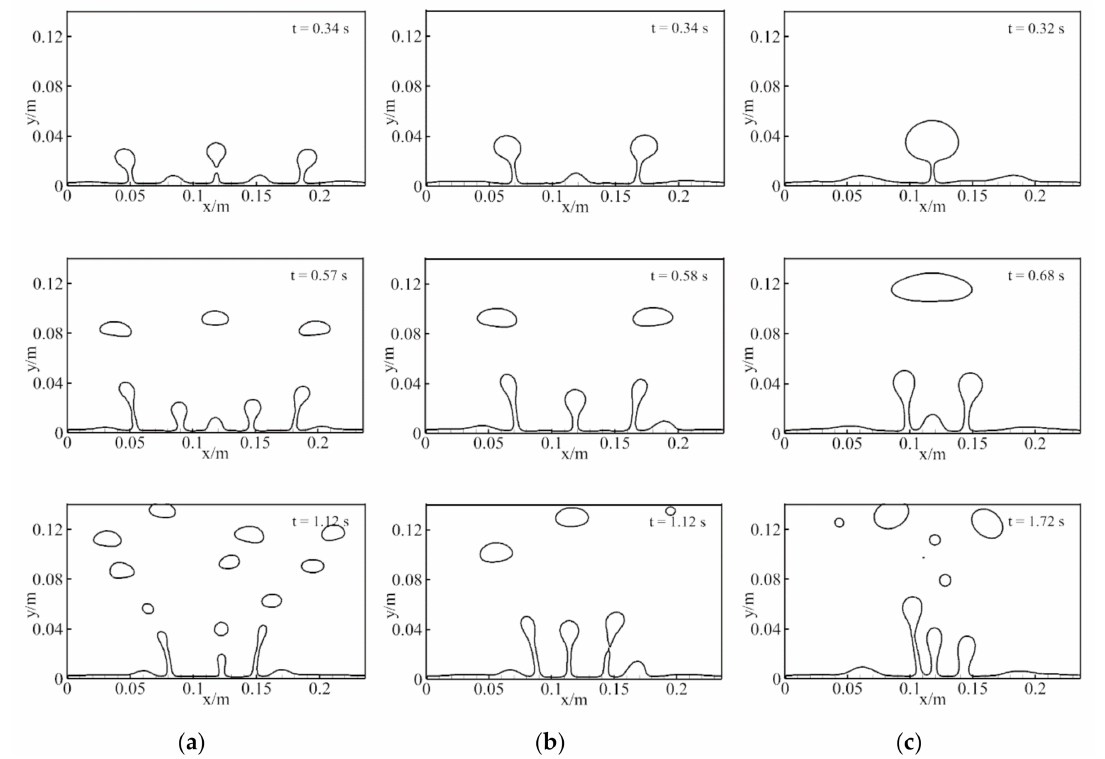
Figure 14. The bubble detachment at different gravity levels when H 0 = 25 kA/m. ( a ) g/ge = 1.0, ( b ) g/ge = 0.44, and ( c ) g/ge =